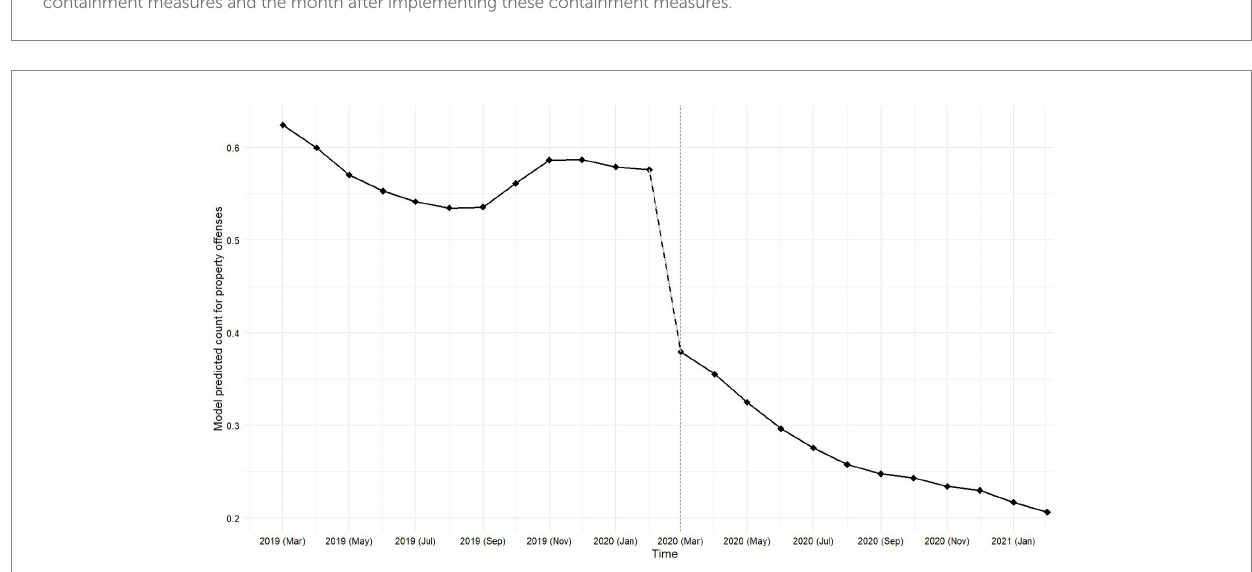
FIGURE 3 Model predicted count for property offenses prior to, at, and following the COVID-19 pandemic by taking seasonality into account. The X-axis represents months prior to (April 2019 to February 2020), at (March 2020, the vertical dashed line), and following (April 2020 to February 2021) the school closures. Y-axis represents the model predicted mean count. The dashed vertical line indicates the month when containment measures started to be implemented. The dashed oblique line highlights the abrupt jump in offense count between 1 month before the implementation of the containment measures and the month after implementing these containment